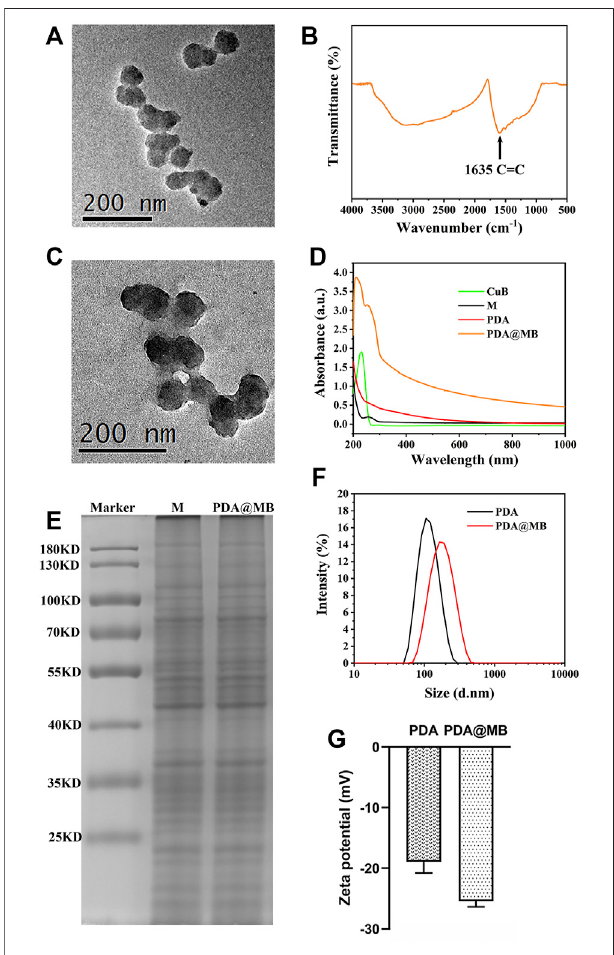
FIGURE 1 | (A) TEM image of PDA. The scale bar is 200 nm. (B) FT-IR spectroscopy of PDA. (C) TEM image of PDA@MB. (D) UV-Vis absorption spectra of CuB, 4T1 cell membrane (M), PDA and PDA@MB. (E) SDS-PAGE- based protein analyses of 4T1 cell membrane (M) and PDA@MB.